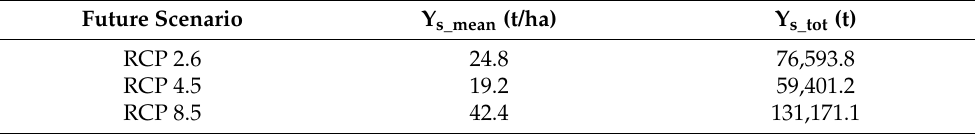
Figure 11. Guerna catchment: map of computed sediment yield (Y s ) applying MUSLE model (4 September 2011 rainfall event and using AMC II to generate surface runoff) and taking into account future scenarios RCP 2.6, RCP 4.5 and RCP 8.5. Table 6. Sediment yield (MUSLE model) in the Guerna catchment, considering the flood event generated by 4 September 2011 rainfall event and different future scenarios (where AMC II was used to generate surface runoff).